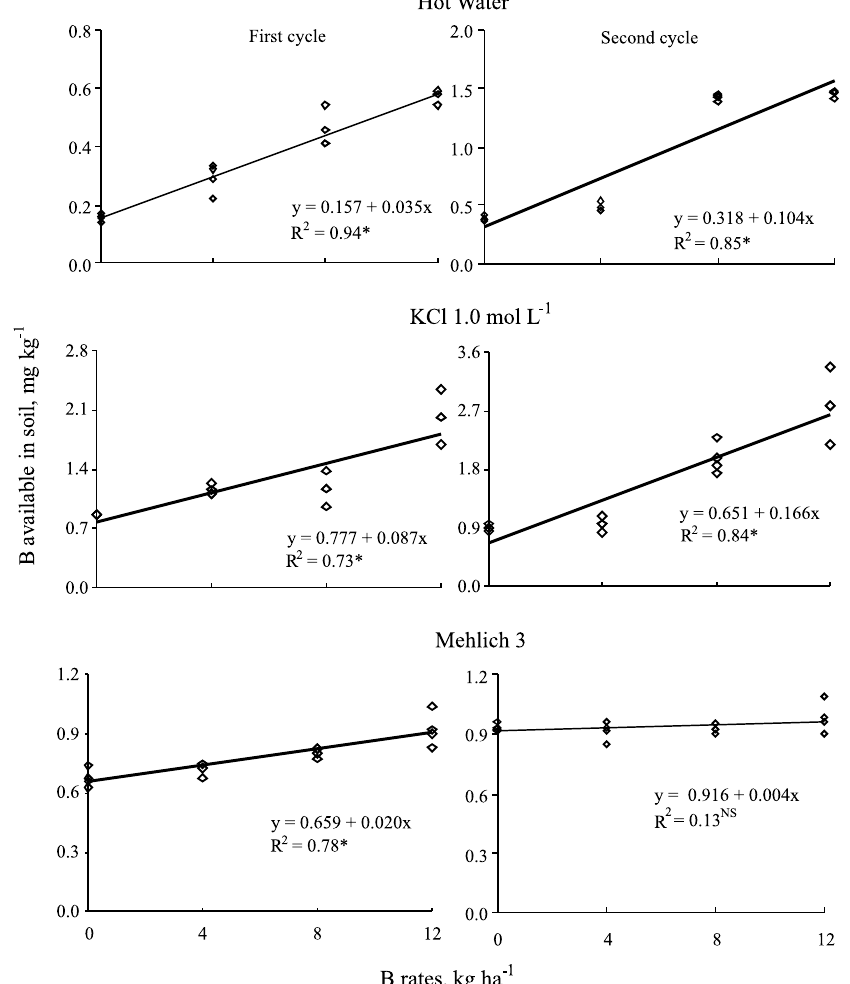
Fig. 3 – Equation of regression among B rates with B available in soil determined with Mehlich 1, KCl 1.0 mol L − 1 and Mehlich 3 extractants. *Significant at 5% level of probability. NS Non-significant by